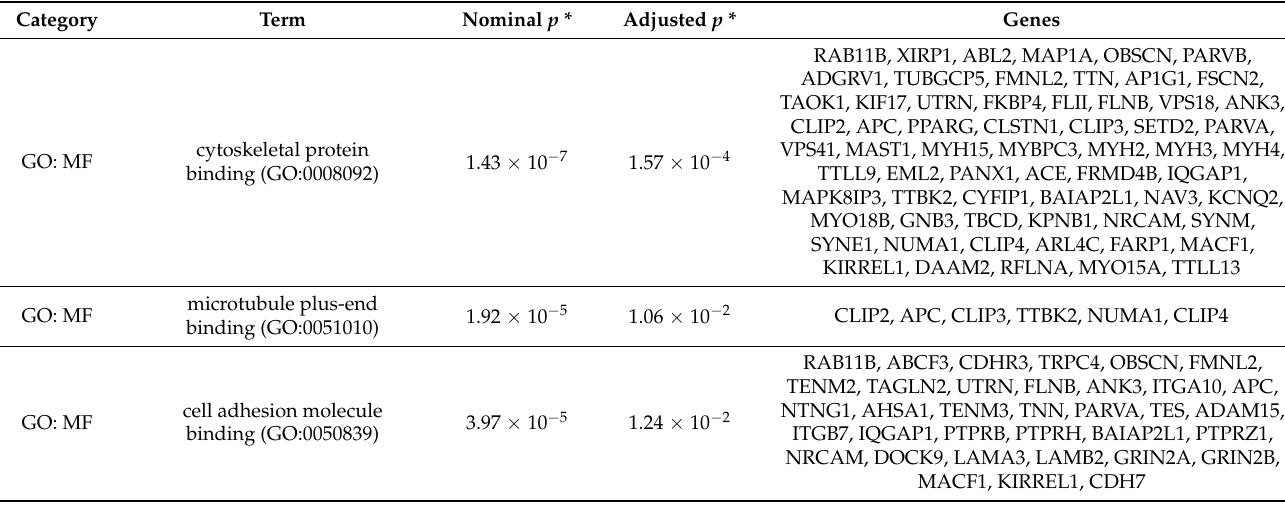
Figure 2. Gene Set Enrichment Analysis for ultra-rare variants in nsCPO and unaffected controls. GSEA for genes carrying protein-altering (lilac), synonymous (purple) ultra-rare variants in nsCPO cases, and protein-altering ultra-rare variants in unaffected controls (pink). The X-axis shows a negative log-transformed BH p -value, and the horizontal dashed line indicates the nominally signifi- cance threshold ( p -value = 0.05). ( A ) BH p -value for genes with protein-altering and synonymous ultra-rare variants in nsCPO and protein-altering ultra-rare variants in unaffected controls for the top 5 significant Molecular Function (GO:MF) terms. ( B ) BH p -value for genes with protein-altering and synonymous ultra-rare variants in nsCPO cases and protein-altering ultra-rare variants in unaffected controls for the top 5 significant pathway terms. Table 1. Genes carrying ultra-rare variants in nsCPO patients belonging to significant Gene Ontology categories identified by gene set enrichment